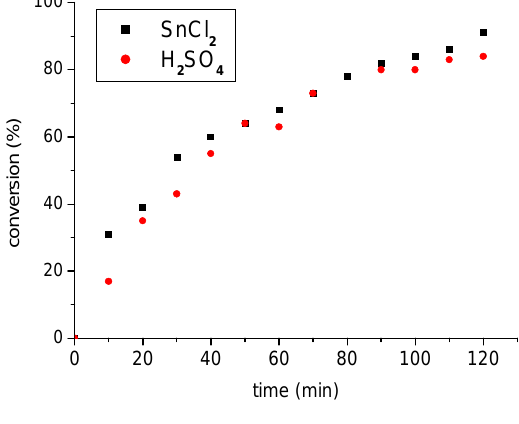
SO ) and Lewis acids (SnCl 2 4